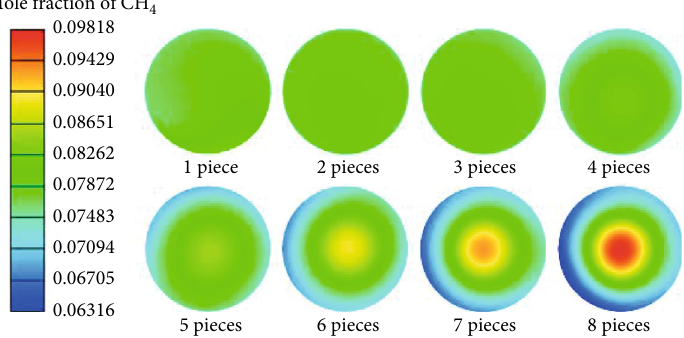
Figure 3: E ff ect of the number of helical blades in the mixing zone on the uniformity.